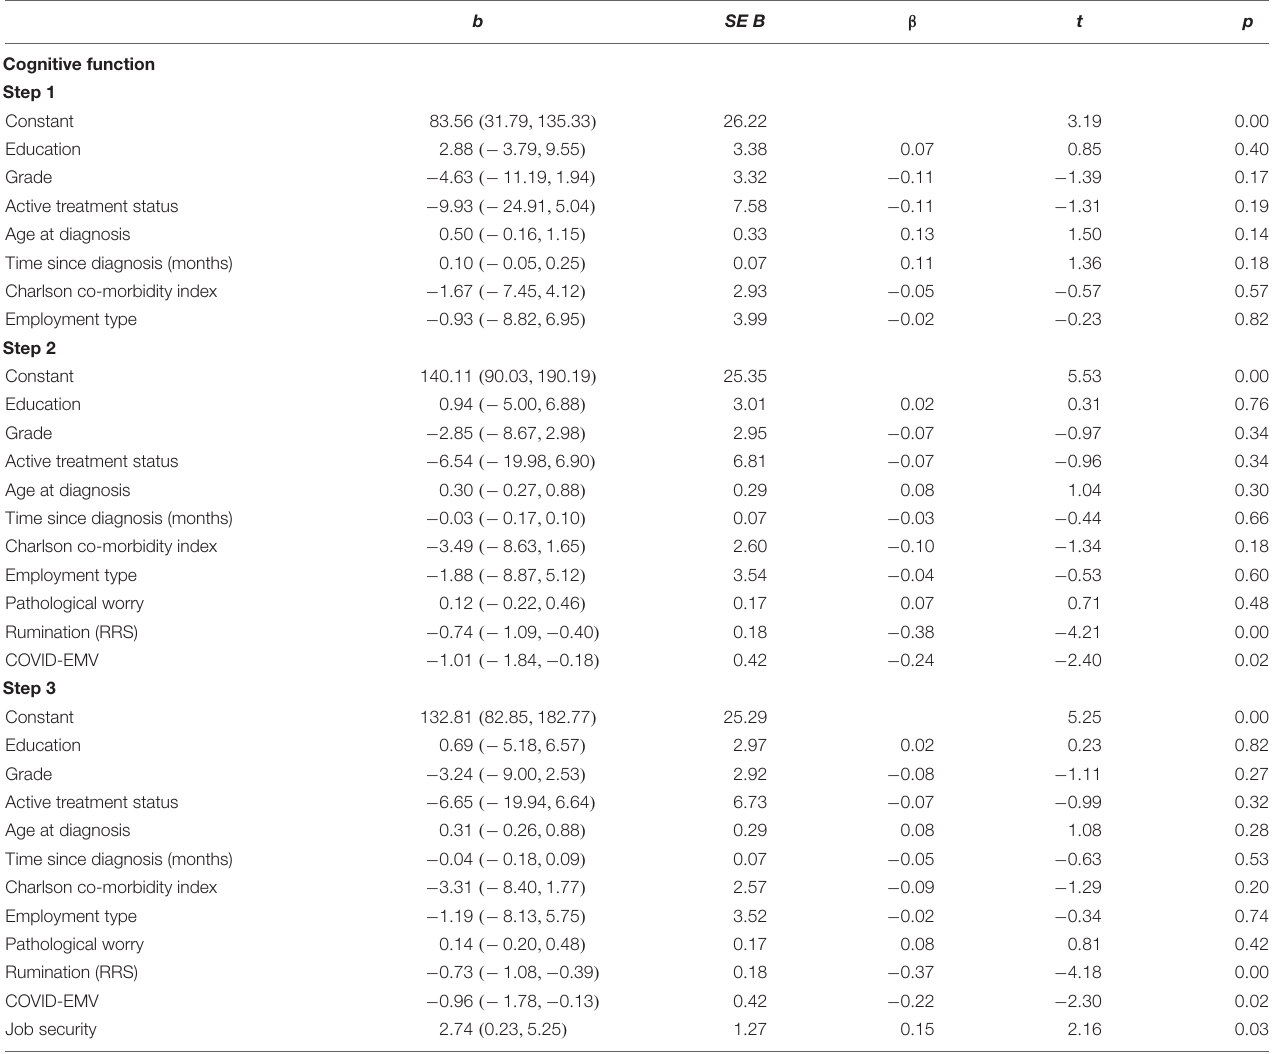
TABLE 6 | Hierarchical regression for the predictors of cognitive